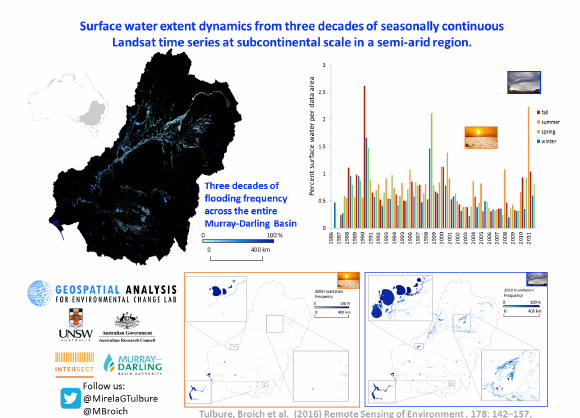
Figure 1. Surface water extent dynamics from three decades of seasonally continuous Landsat time series at subcontinental scale in a semi-arid